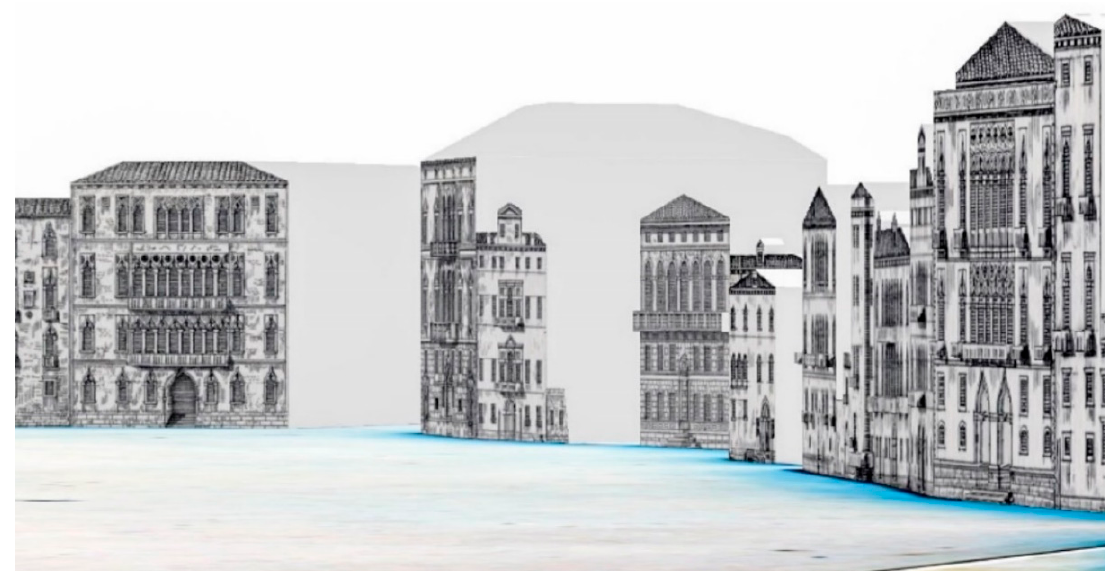
Figure 6. View of the LoD3 city model near Ca’ Foscari.